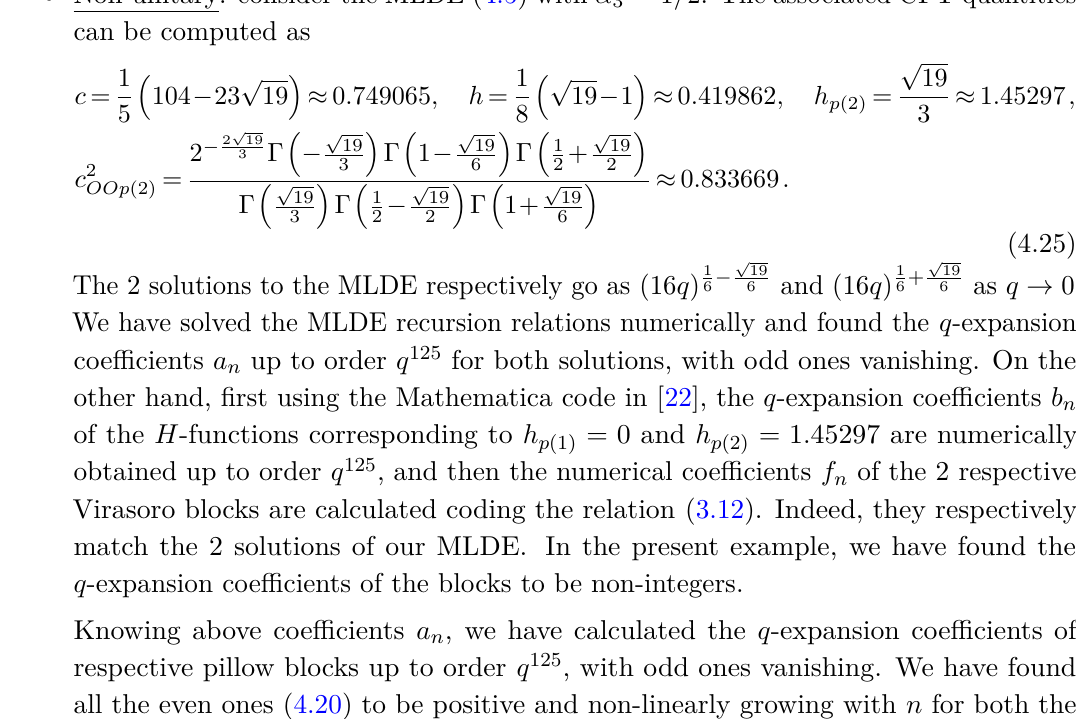
is plotted against α OOp (2)